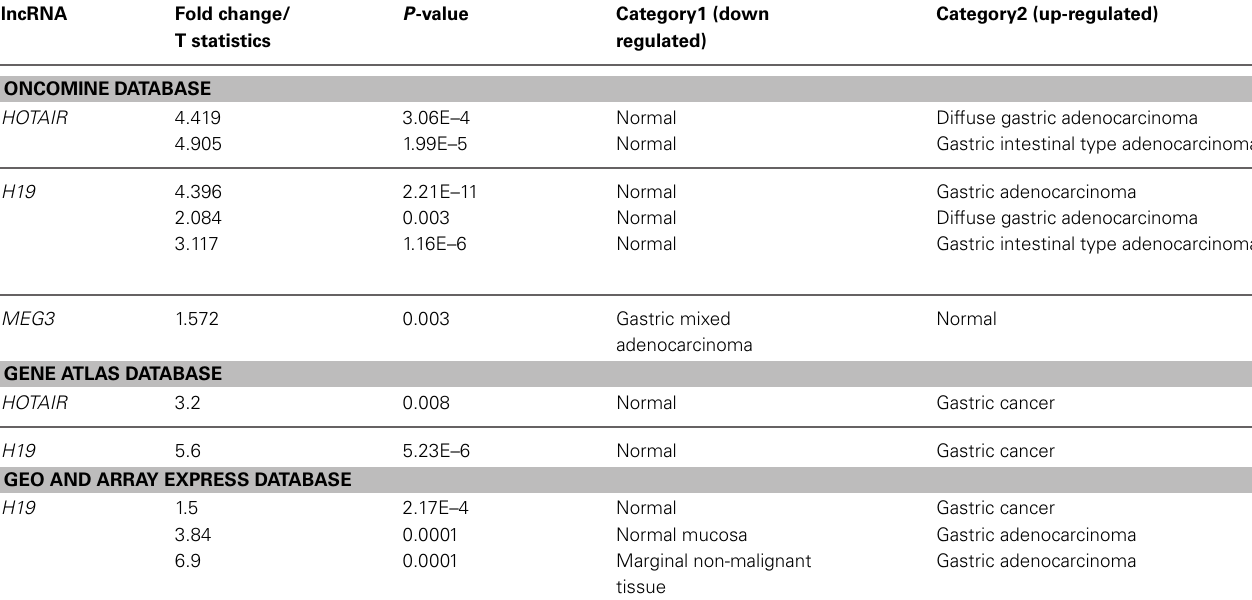
Table 2 | Significant difference (Fold change > 1.5, P -value < 0.01) of the expression level of lncRNAs between gastric cancer types and normal